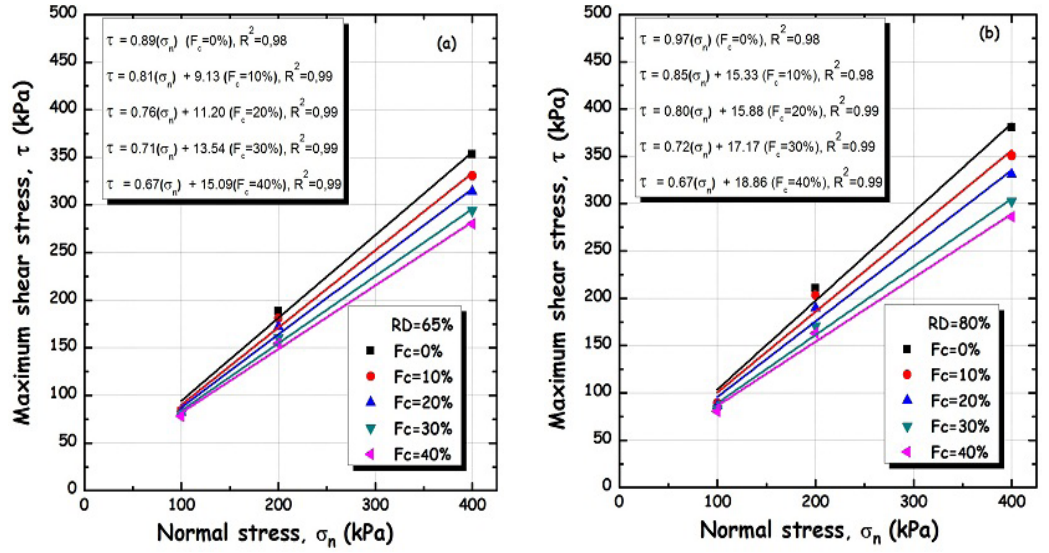
Figure 10: Effect of fines content on the mechanical behaviour of sand: Maximum shear stress versus normal stress.